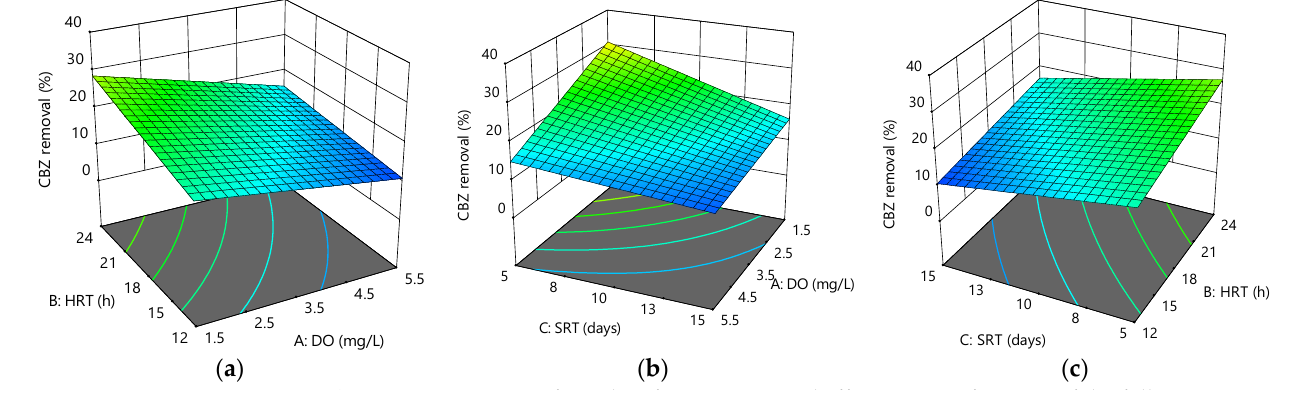
Figure 3. Response surface plots for CBZ removal efficiency as a function of the following: ( a ) HRT and DO at SRT = 10 days; ( b ) SRT and DO at HRT = 18 h; ( c ) HRT and SRT at DO = 3.5 mg/L.